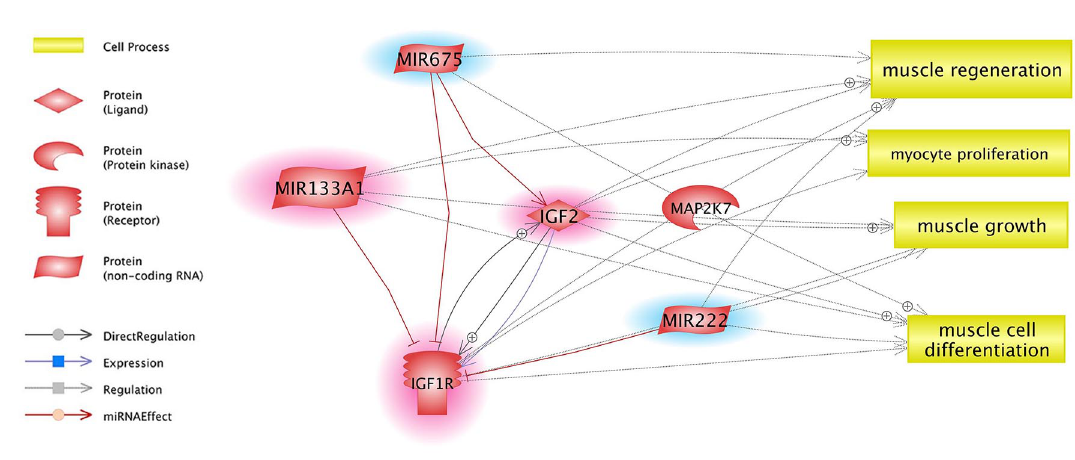
Figure 6. Relationships between DET and miRNAs, based on Pathway Studio Web Mammal. Genes are marked with red clouds and blue clouds for up- and down-regulation,